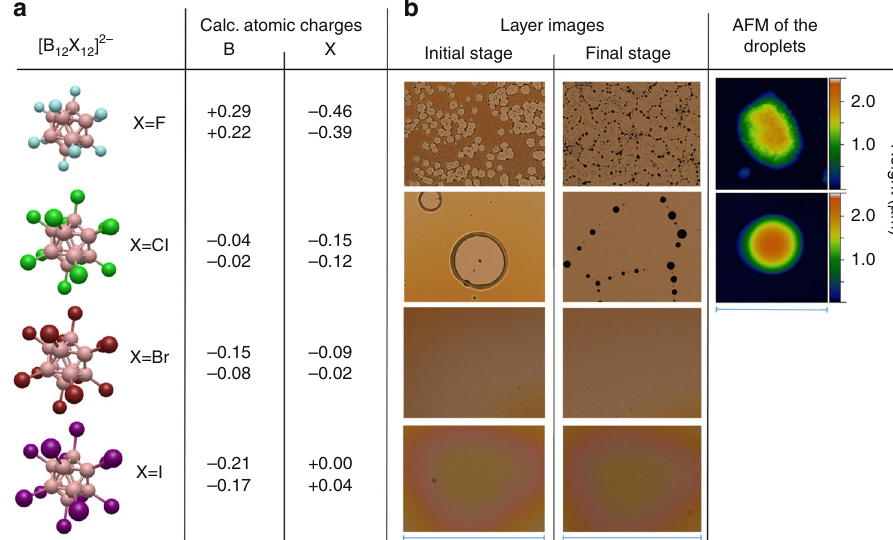
Fig. 3 Comparison of atomic charges and self-organization of the anion-based layers under ambient conditions. a Calculated atomic charges (highest and lowest values) 74 of boron and halogen atoms obtained using different population analysis methods (Natural Population Analysis (NPA) and CHarges from ELectrostatic Potentials using a Grid-based method (CHELPG)) and b bright fi eld optical microscopy images (scale bars = 540 µ m) showing layer morphology after soft landing of the family of [B 12 X 12 ] 2 − ions on FSAM. For X = Br, I, the layers were stable and did not change over a timeframe of days, while dewetting was observed for X = F, Cl. The initial stage of hole formation and fi nal stage (after droplet formation) are shown. AFM images (scale bar = 15 µ m) of the droplets formed in the fi nal stage showing a liquid-like droplet for X = Cl and a droplet with a solid-like grainy morphology for X = − – FSAM may destabilize the layer. The [B 12 X 12 ] 2 FSAM inter-